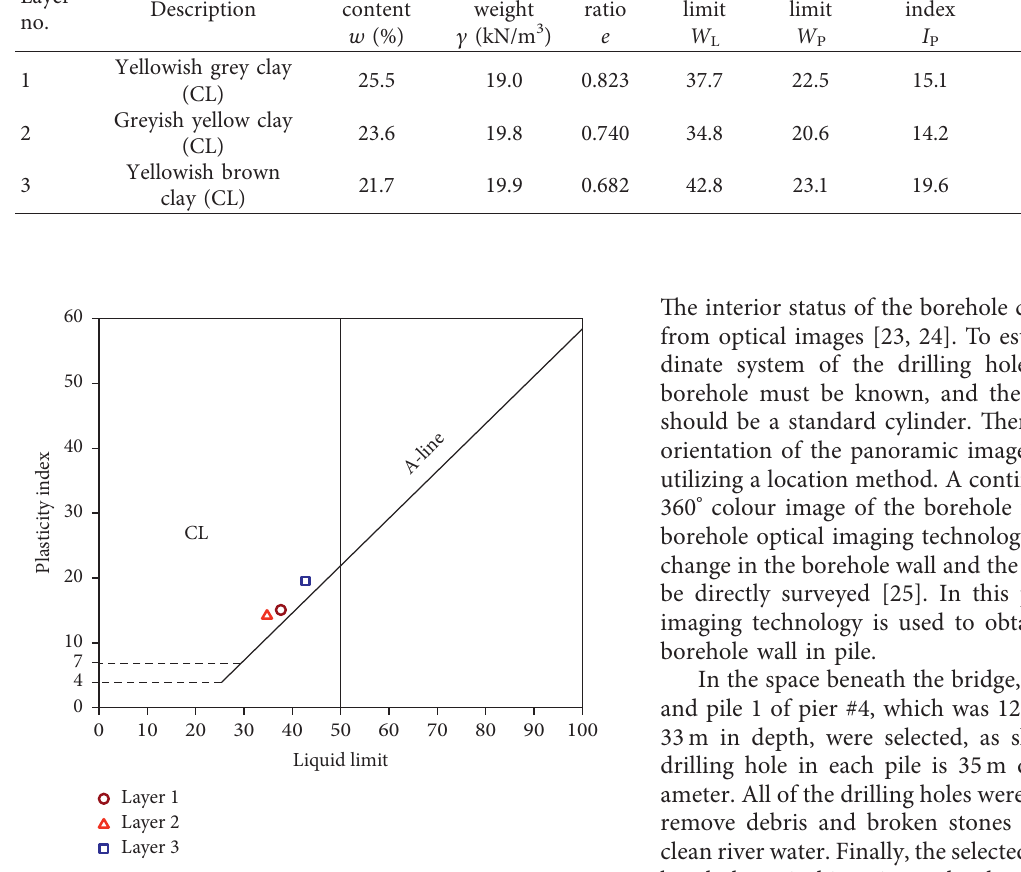
Figure 4: Plasticity